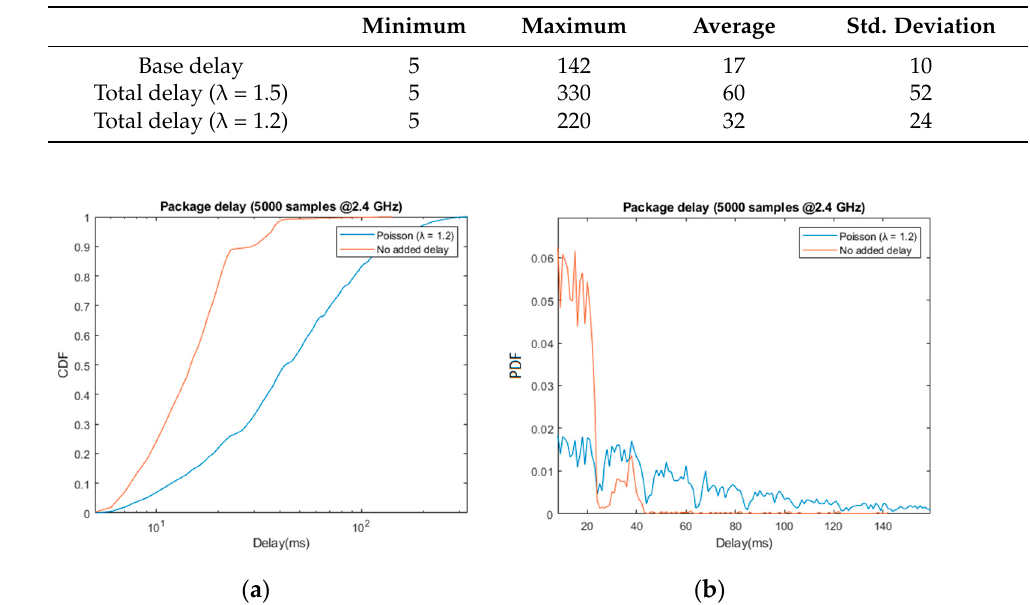
Figure 8. Capture of the update data’s delay before (orange) and after (blue) adding jitter, λ = 1.2. The graphs show the cummulative distribution function ( a ) and the probability distribution function ( b ) of the sample (5000 packages sent).